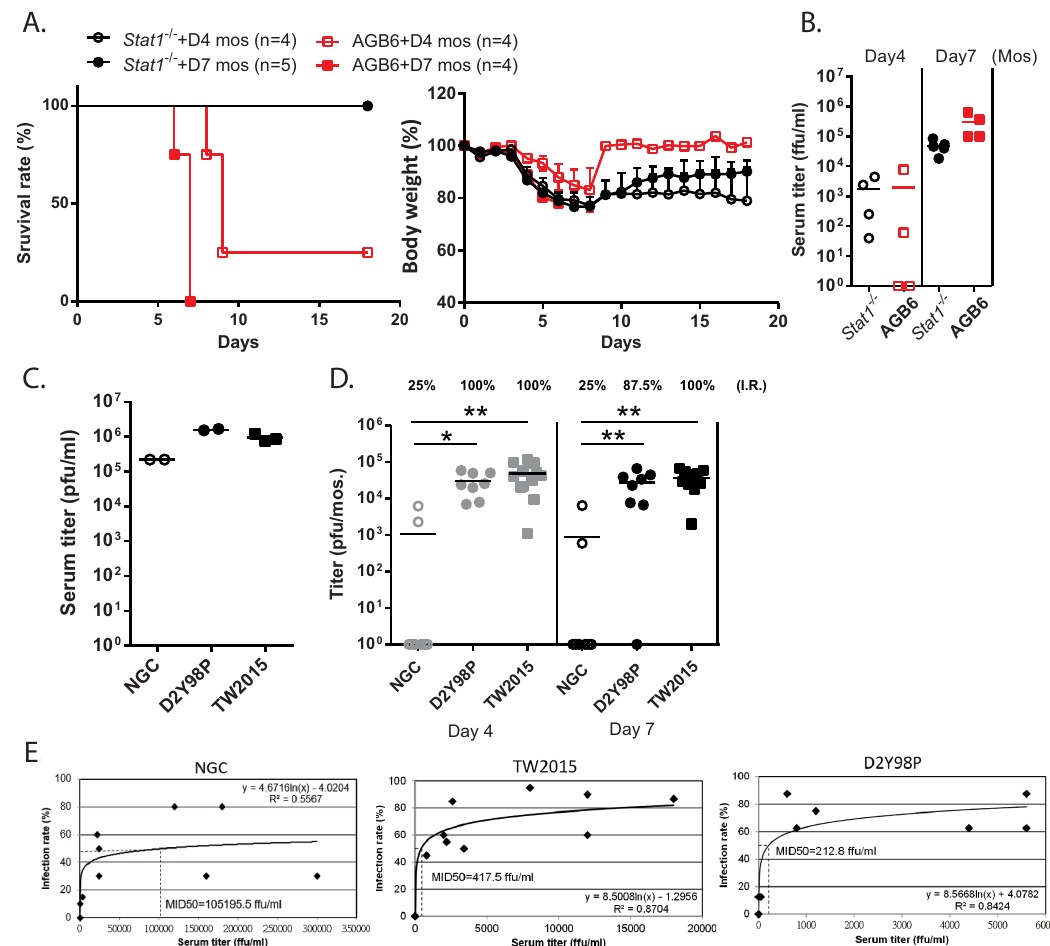
Fig 3. The TW2015 virus had high Aedes aegypti mosquito-mediated transmissibility to mice. (A-B) The TW2015-infected Aedes aegypti mosquitoes (Day 4- or 7-post-thoracic injection) took blood meals from Stat1 -/- or AGB6 mice (8–15 engorged mosquitoes/mouse). (A) Mouse survival rate and body weight were monitored daily (n = 4–5). (B) Mouse viremia as assessed by plaque assay on day 3 after mosquito (mos) exposure. (C-D) DENV2-infected AGB6 mice (iv, 2000 pfu/mouse; 3 dpi; n = 2–3) were used to feed mosquitoes, and the infection rate in the blood-engorged mosquitoes was evaluated. (C) Viral titer in mouse serum collected immediately following mosquito blood meals from the infected mice. (D) Viral titer in whole mosquito (mos) homogenate and infection rate (I.R.) were analyzed (n = 8–12) following incubation of blood-engorged mosquitoes at 28˚C for 4 or 7 days. � p < 0.05, �� p < 0.01 (E) Aedes aegypti mosquito infectious dose of 50% (MID50) of DENV strains. For more detail, see Materials and Methods. TW2015-infected mosquitoes. Mosquitoes carrying either the NGC or TW2015 viruses (10–21 mosquitoes/mouse) could transmit the viruses to AGB6 mice and cause mortality (Fig 4C). However, the TW2015-infected mice died several days earlier than the NGC-infected mice. Viremia was present in these DENV-2 infected mice at both 3 and 4 dpi (Fig 4D). These results demonstrated that both DENV-2 strains could be transmitted from intrathoracic infected mosquitoes to mice. To examine whether the viruses could be transmitted from mice back to mosquitoes, virus- free mosquitoes were allowed access to a blood meal from viremic AGB6 mice at 3 and 4 dpi. When mosquitoes were collected directly following a blood meal, only 20–40% of the engorged mosquitoes taking 3 dpi-viremic blood were DENV-positive, but 100% of the mosquitoes that fed on 4 dpi-viremic blood were DENV-positive in their midgut (Fig 4E, left panel). After 7